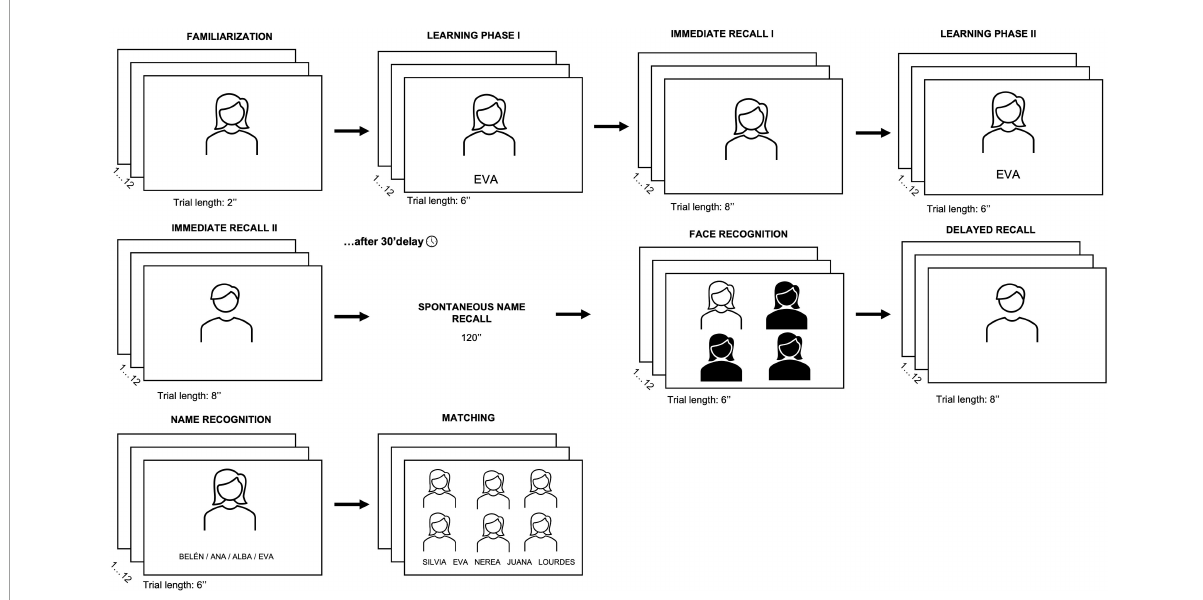
FIGURE1 Outline of the extended and modified FNAME paradigm used. “The participants underwent two learning trials (Learning I and Learning II) to all the 12 face-name pairs. Following each trial, they were asked to provide the name associated with each face (Immediate recall I and II). Face-name pairs that were not remembered were shown again to the participant. After a 30-min delay, free recall, recognition and matching tasks followed. First, participants were asked to freely recall all names they learned within 2 min (Spontaneous recall). Next, they were asked to recognize the previously learned face out of 4 (Face Recognition). Then, they were again asked to say the name associated with each face (Delayed recall). After that, participants were asked to select the name associated with the face from among four items (Name recognition). Finally, participants were instructed to match the correct name to the corresponding face among the 6 presented (men and women were presented separately in the Matching phase). Participants’ responses were produced orally and recorded on a scoring